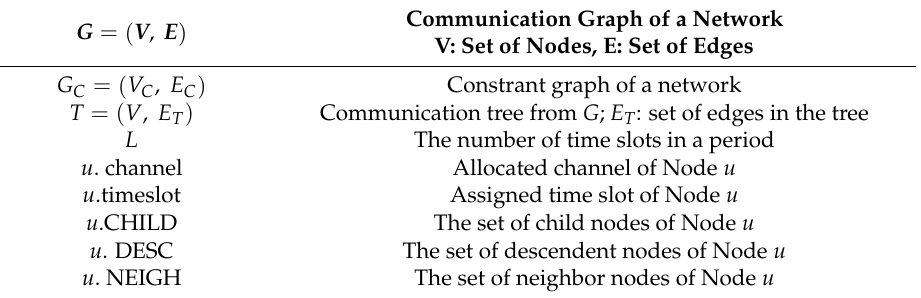
Table 1. List of notations.